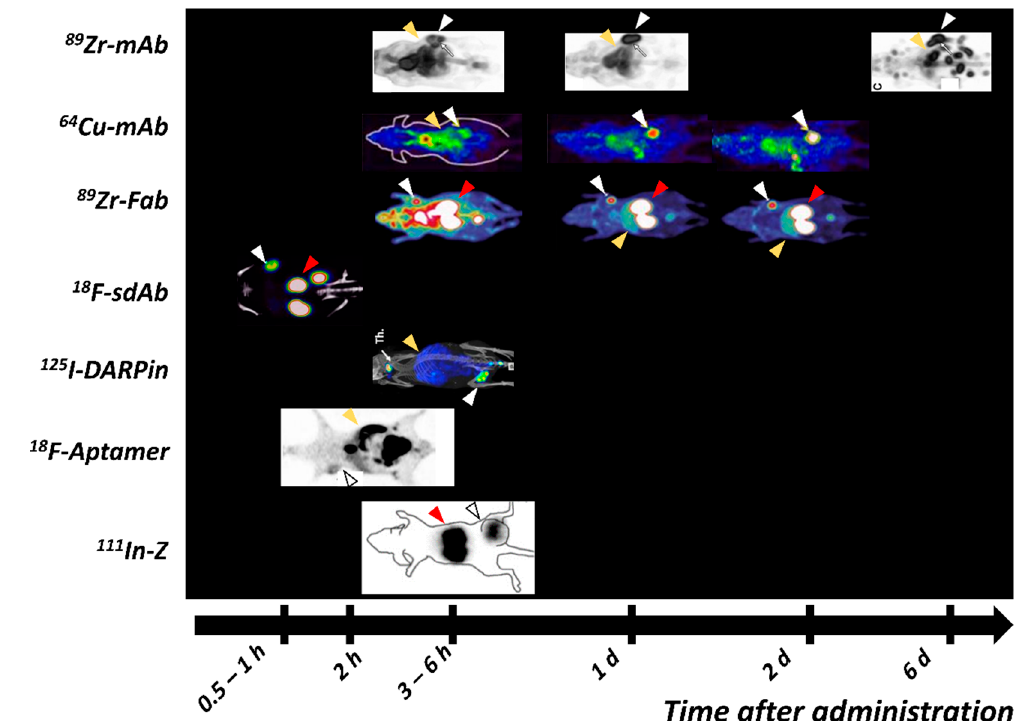
Figure 4. Imaging of HER2 expression (white arrows) in xenografted mice using monoclonal antibodies ([ 89 Zr]Zr-trastuzumab [84] and [ 64 Cu]Cu-pertuzumab [194]), [ 89 Zr]Zr-Fab (PASylated fragments of trastuzumab [207], 18 F-labeled sdAb [217], 125 I-labeled DARPin (G3 [224], 18 F-labeled aptamer [225], and 111 In-labeled affibody molecule (ABY-025 [226], abbreviated 111 In-Z). Yellow arrows point to uptake in the liver and red arrows in the kidneys. These images were originally published in JNM [84,207,217,226] © SNMMI, Int J Mol Sci [224], and PLoS One [225].